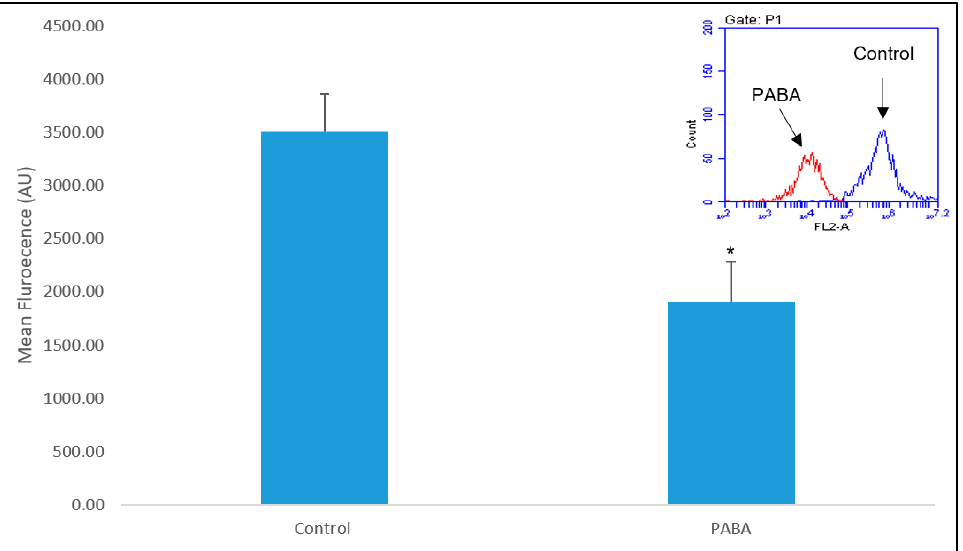
Figure 3. The cellular CoQ 10 concentration, after treatment with 5 µM CoQ 10 over 3 days. Figure shows concentration of CoQ 10 after PABA treatment and subsequent CoQ 10 treatment. CoQ 10 concentration standardised to protein baseline (mg of protein). Comparison of groups was carried out as follows: control group vs. PABA, Control group vs. Control CoQ 10 treated, PABA group vs. PABA CoQ 10 treated. Data available in supplemental data under Table S3. Level of significance * p < 0.05, ** p < 0.05; n =